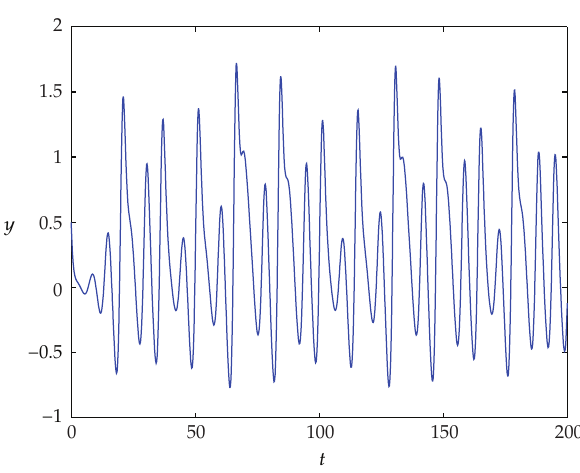
Figure 4: State trajectory of y